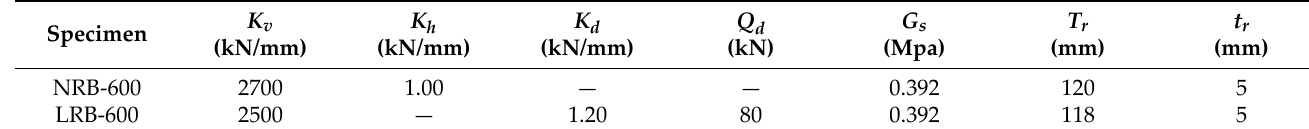
Figure 1. Test specimen of the two rubber bearings: ( a ) NRB ‐ 600 specimen; ( b ) LRB ‐ 600 specimen